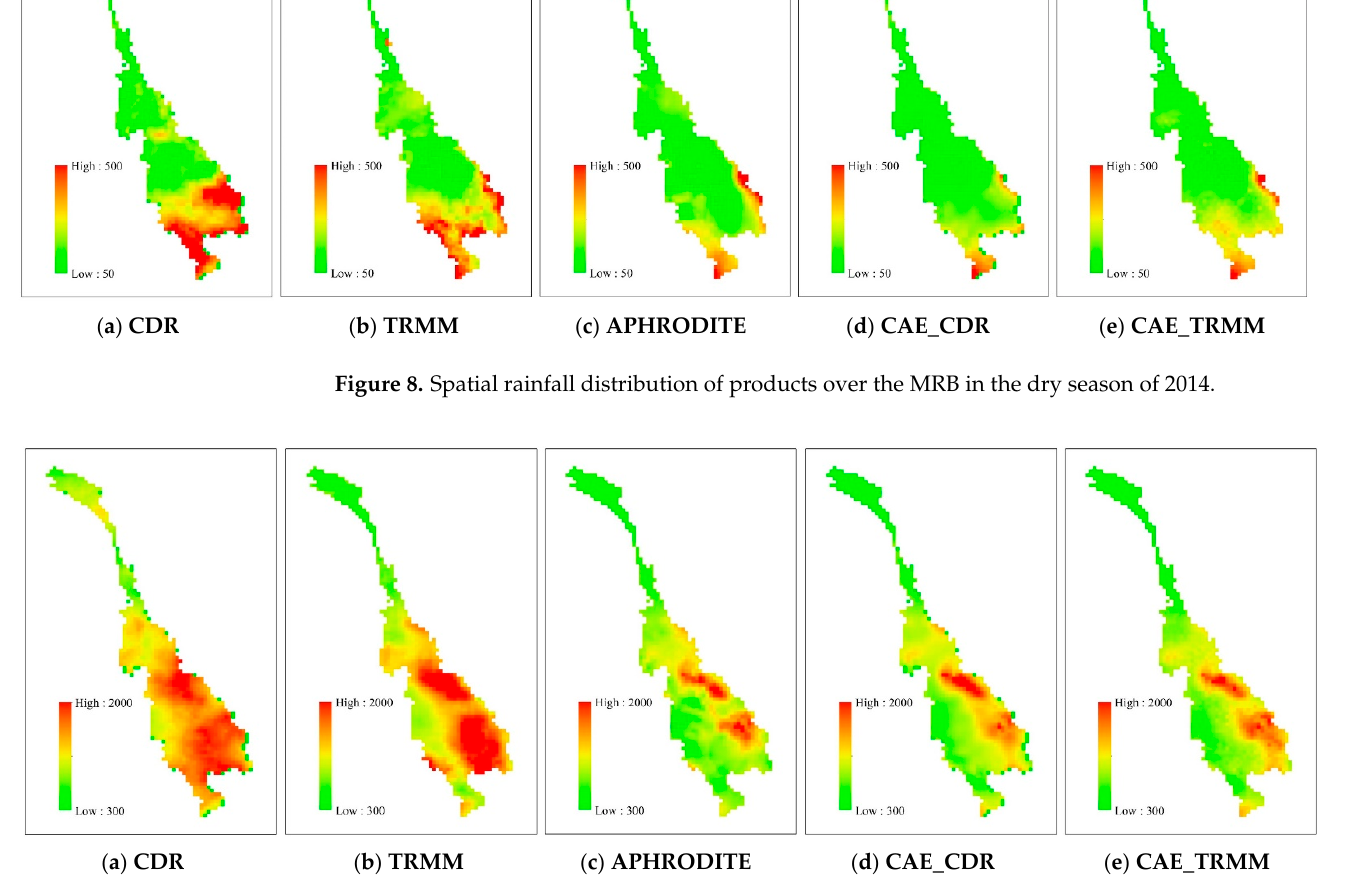
Figure 9. Spatial rainfall distribution of products over the MRB in the wet season of 2014.